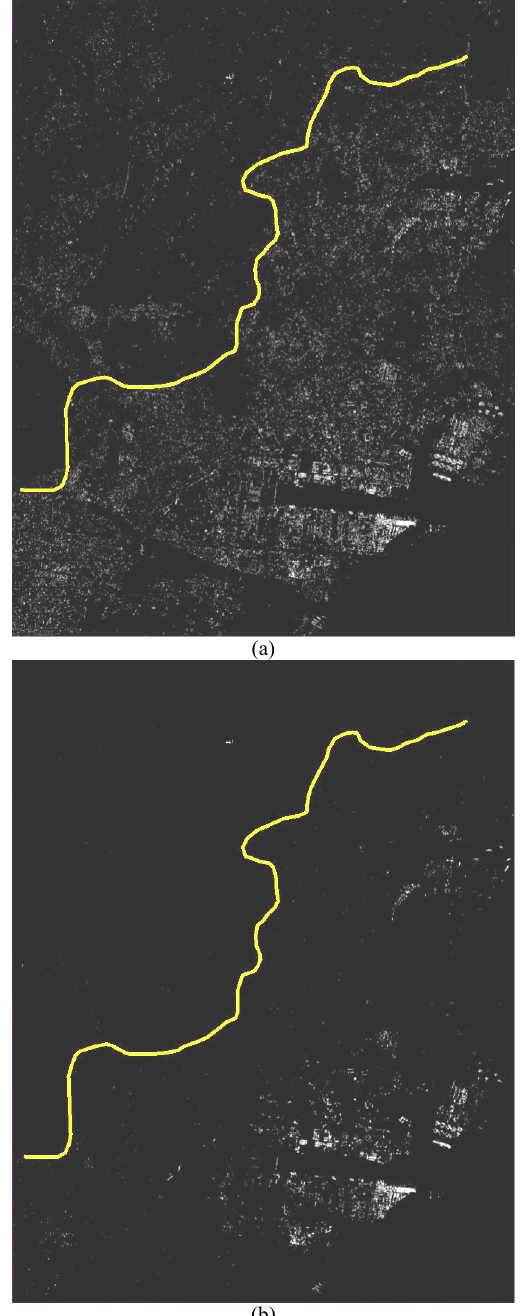
(b) (b) Figure 7. The extracted change areas (white) by Curvelet-based Figure 6. (a) The (stretched) difference image of the pre- and approach (b) and without Curvelet filtering (a). The yellow line post-event TSX images. The yellow line indicates the boundary indicates the boundary between the flood-free and flood- between the flood-free and flood-influenced areas. The bright influenced and dark areas indicate the nominal changes caused by various reasons; otherwise, the common gray areas are interpreted as the unchanged areas. (b) The difference image resultant of Curvelet filtering on the one shown in (a).